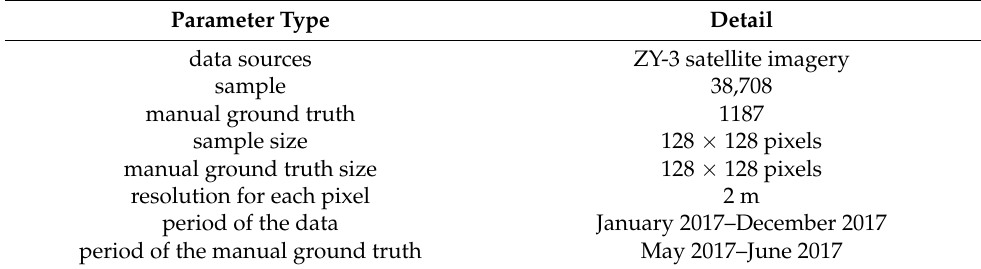
Table 2. Detail information for the proposed